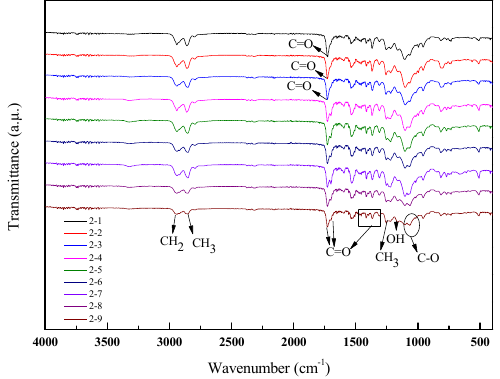
Figure 5. FTIR spectra of polyether-based TPUs.